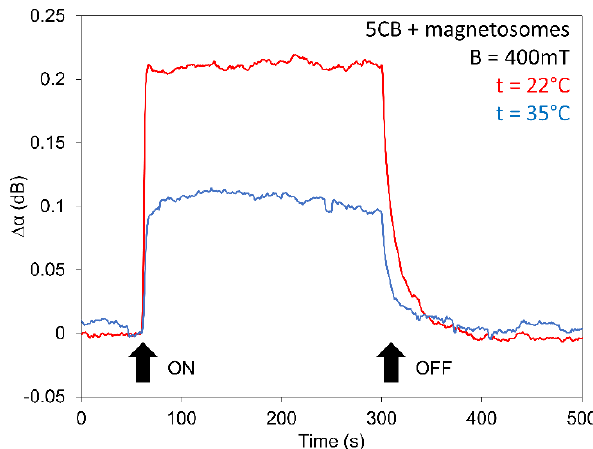
Figure 9. Effect of jumped magnetic field (400 mT) on SAW attenuation of 5CB doped with magne- tosomes (0.2 wt%) at two different temperatures, one in nematic (22 °C) and another in isotropic (35 °C) state.